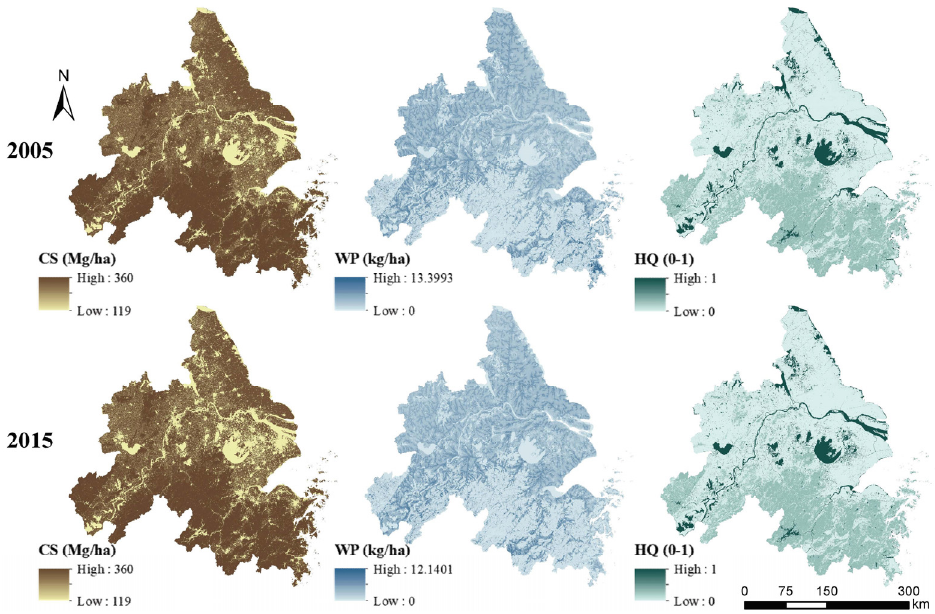
Figure 5. Spatial patterns of ESs in the YRD region at the grid scale (CS: carbon storage; WP: water purification; HQ: habitat quality).